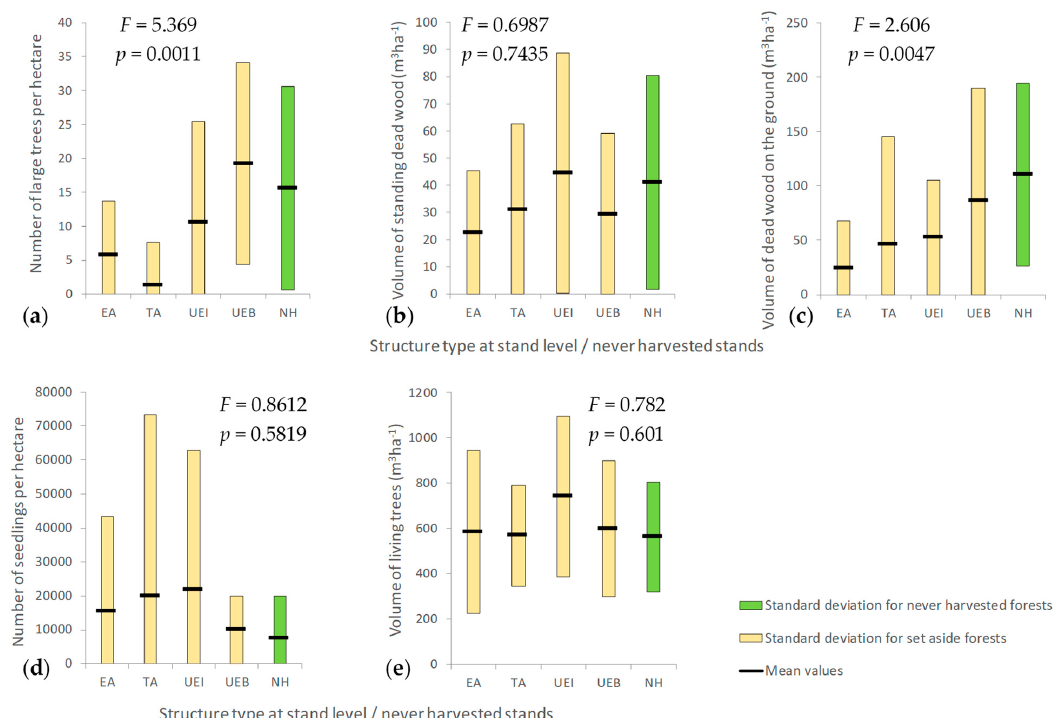
Figure 10. Closeness of set-aside forests to old-growth forests in terms of: ( a ) number of large trees per hectare, ( b ) volume of standing dead trees, ( c ) volume of deadwood on the ground, ( d ) natural regeneration, ( e ) volume of living trees (EA—even-aged; TA—two-aged; UEI—uneven-aged irregular; UEB—uneven-aged balanced; NH—never-harvested forest stands).